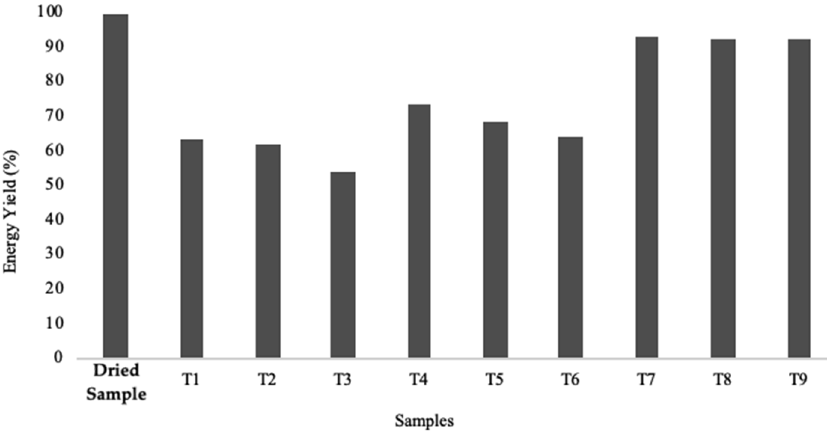
Figure 11. Graphic representation of the mass yield obtained for dry and all torrefied samples. Dry biomass was used as the control sample.